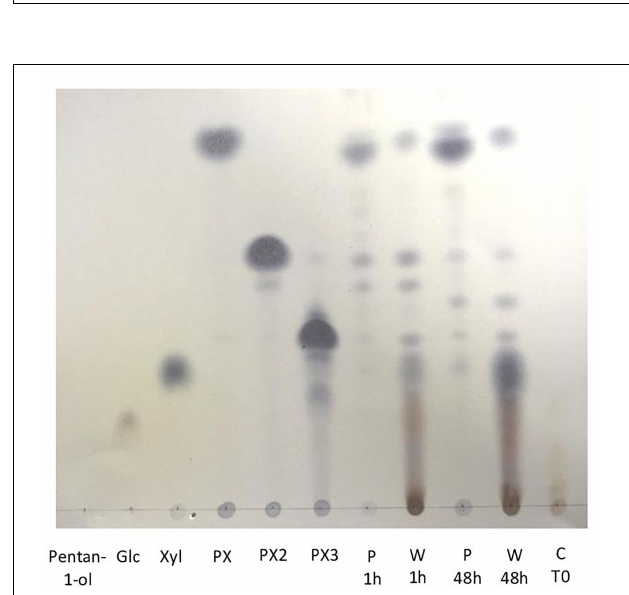
FIGURE 2 | TLC analysis of pentyl β -D xylosides produced from transglycosylation reaction catalyzed by Cellic Ctec2 in presence of wheat bran and pentanol 50% in water (v/v) during 48 h at 50 ◦ C. Pentanol, glucose, xylose, pentyl xyloside DP1 (PX) pentyl xyloside DP2 (PX2) and pentyl xyloside DP3 (PX3) were used as standards. Aqueous (W) and pentanol (P) phases were recovered after 1 and 48 h of the transglycosylation reactions. C T0 corresponds to a control transglycosylation reaction at time